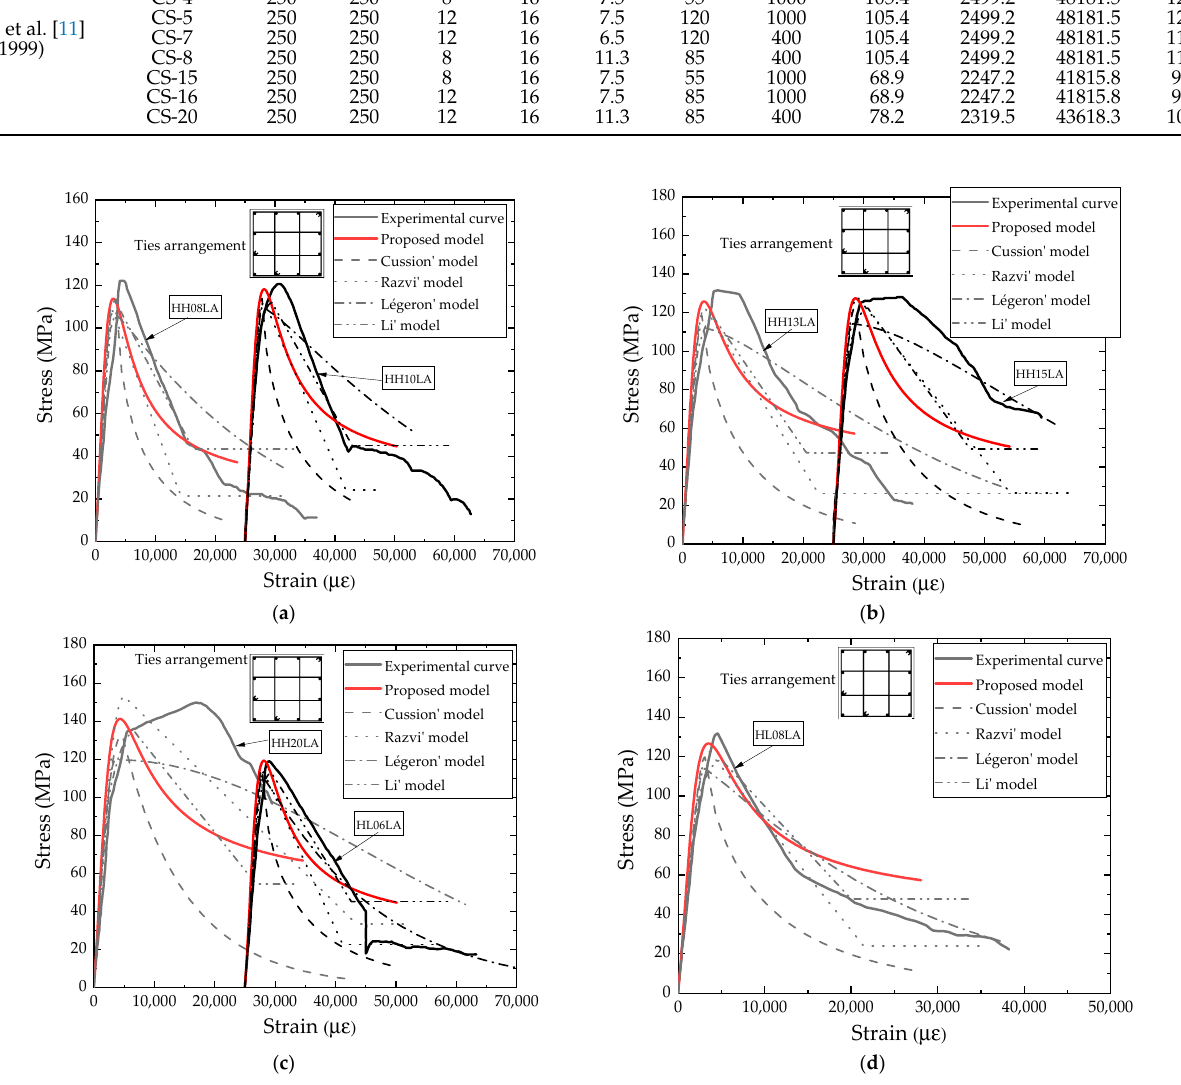
Figure 16. Comparison of experimental curves and analytical models (Nagashima,1992): ( a ) HH08LA and HH10LA; ( b ) HH13LA and HH15LA; ( c ) HH20LA and HL06LA; ( d ) HL08LA.